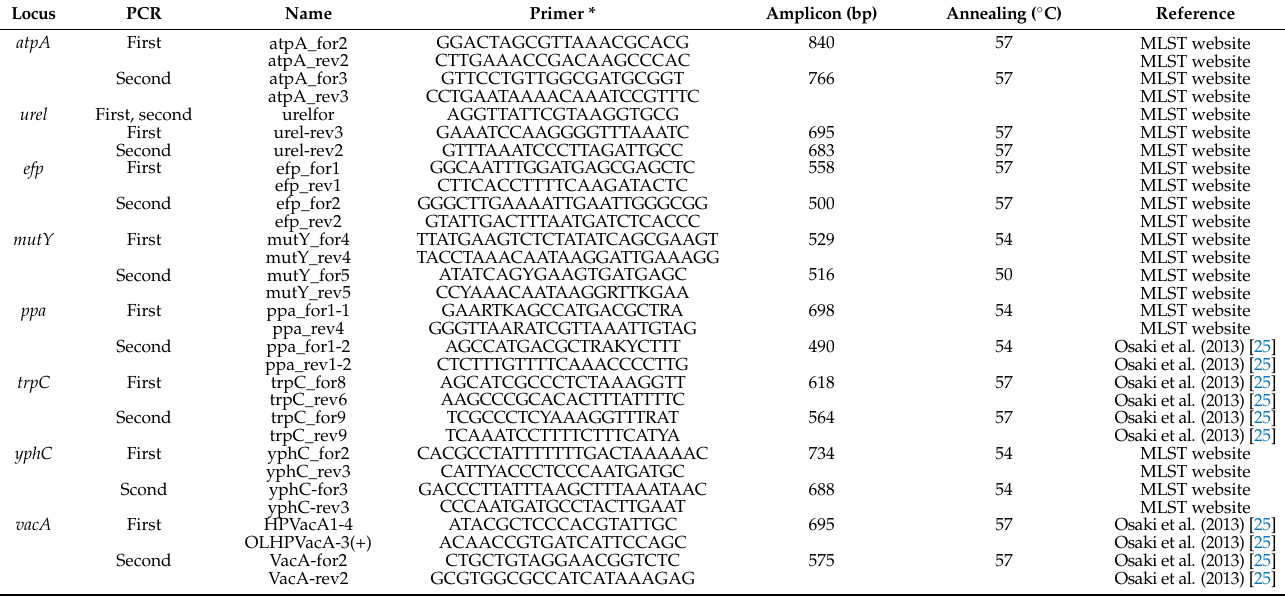
Table 5. Primers for amplification of housekeeping genes using nested